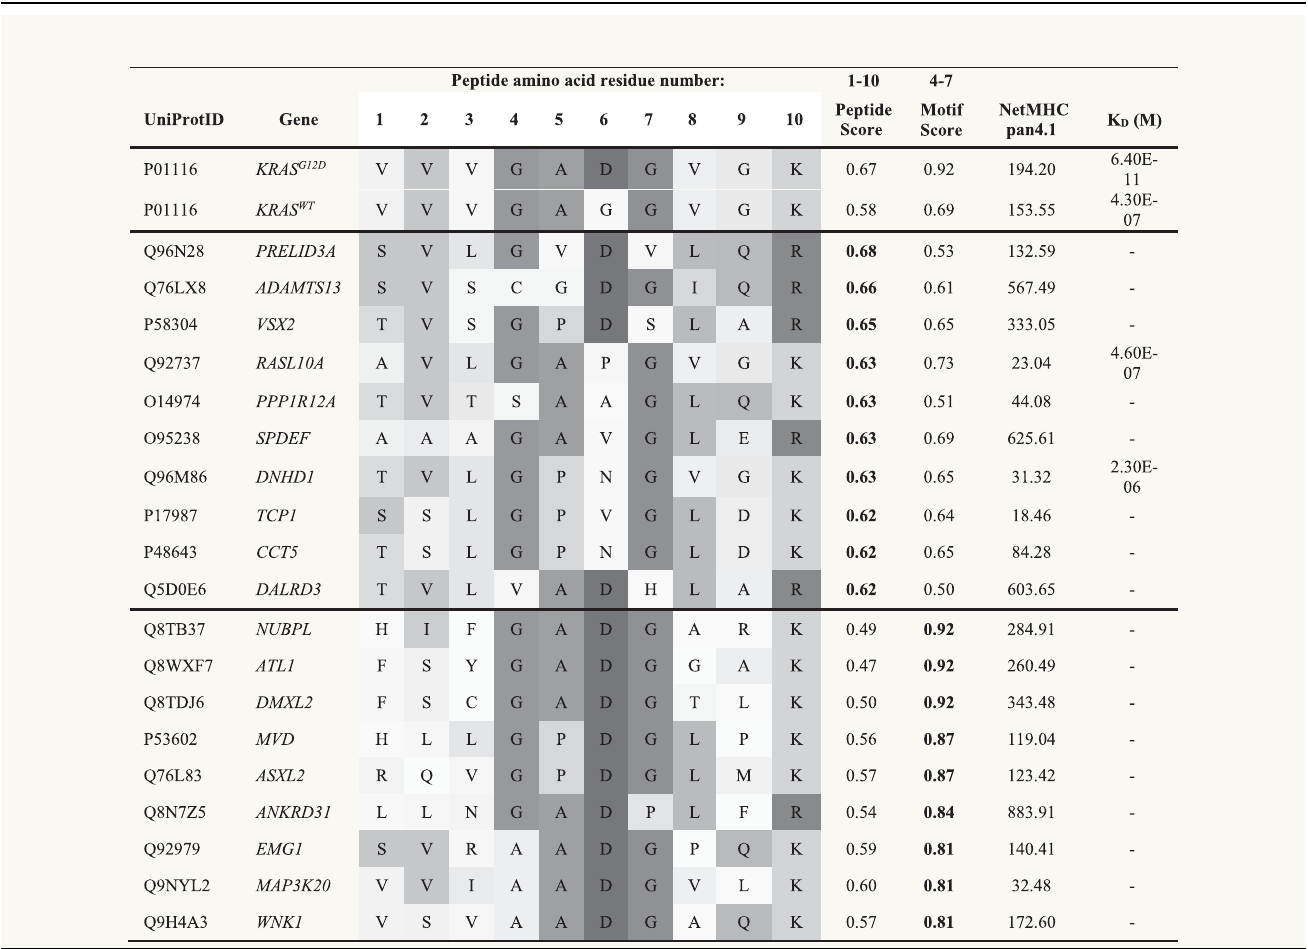
Table5|Mimeticpeptidesselected fromthehumangenomebased onthe bindingmotifdeterminedusing scHLAphagelibrary